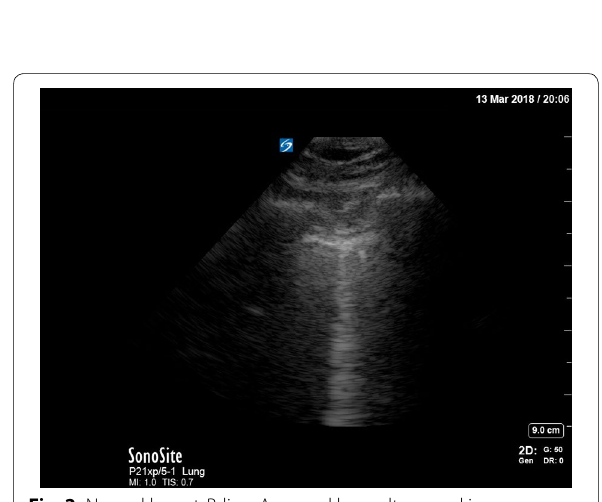
Fig. 2 Normal lung B‑line. A normal lung ultrasound image + acquired with a 5–1 MHz phased‑array cardiac transducer. In the middle of the image, one B‑line is seen. This is also seen in healthy subjects and a single B‑line is without